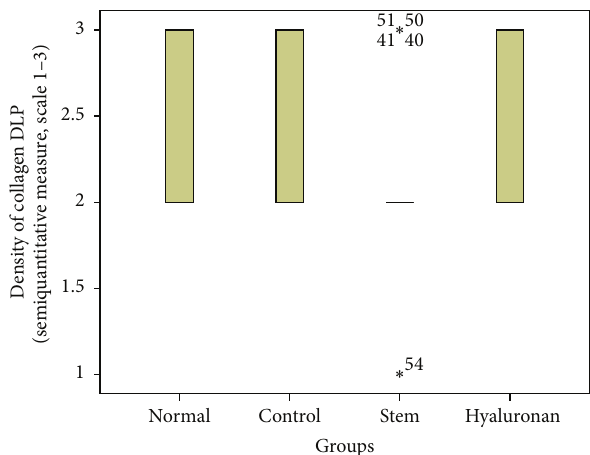
Figure 18: Density of elastin in the intermediate lamina propria (ILP). Normal = normal/control group, control = scarred/control group, stem = stem cell group, and hyaluronan = hyaluronan